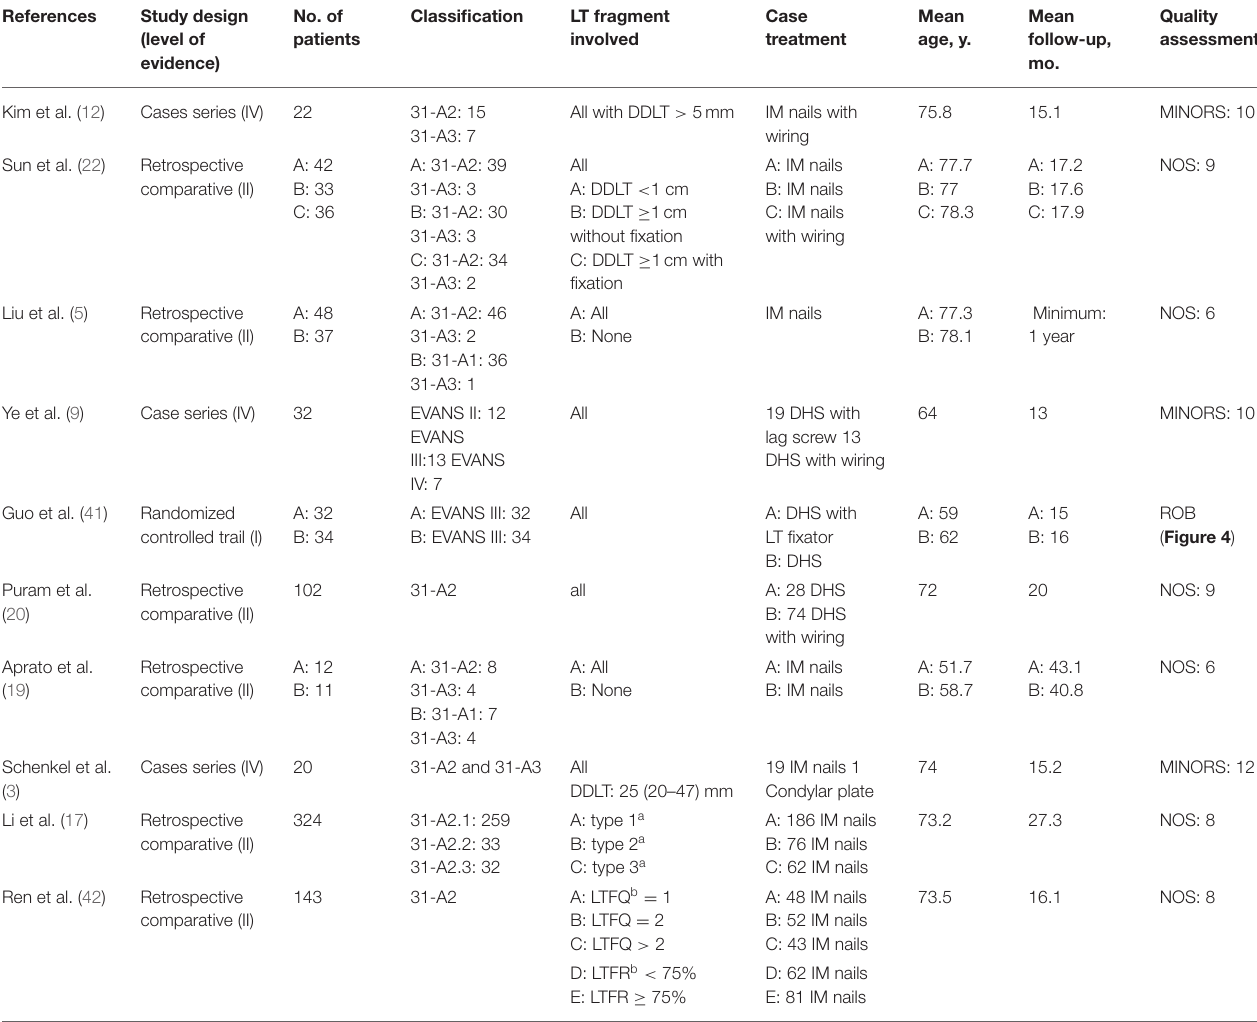
TABLE 1 | Characteristics of included clinical